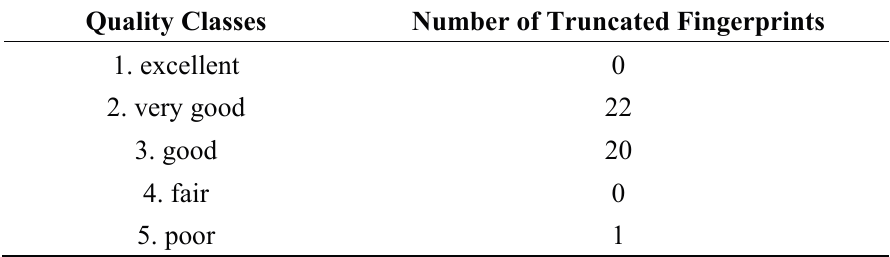
Table 1. Distribution of collected 43 truncated fingerprints according to NFIQ